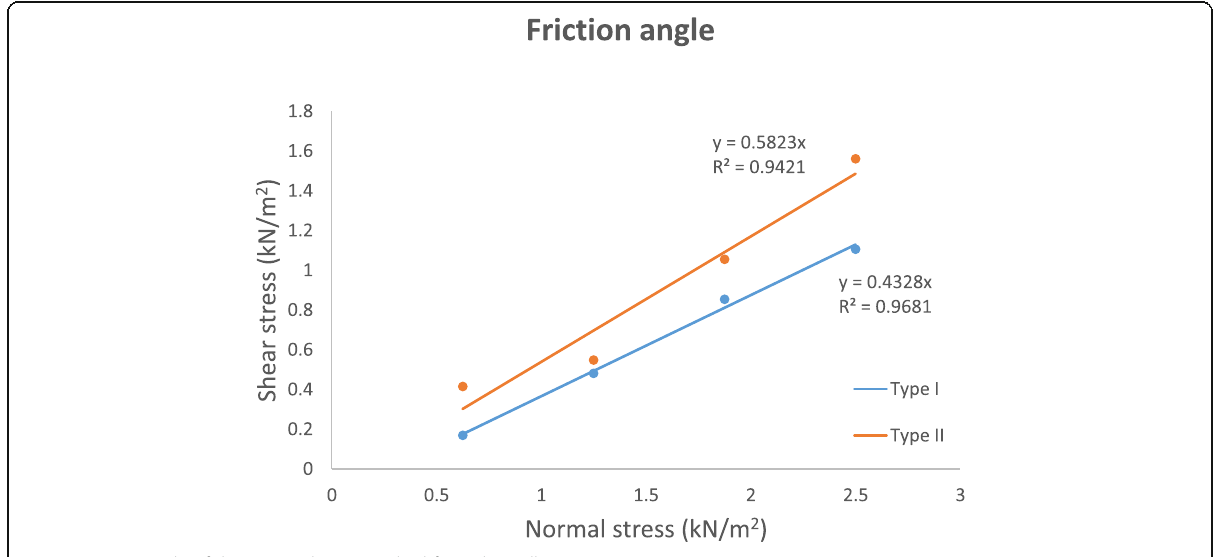
Fig. 5 Friction angle of the geosynthetics resulted from the pull-out test